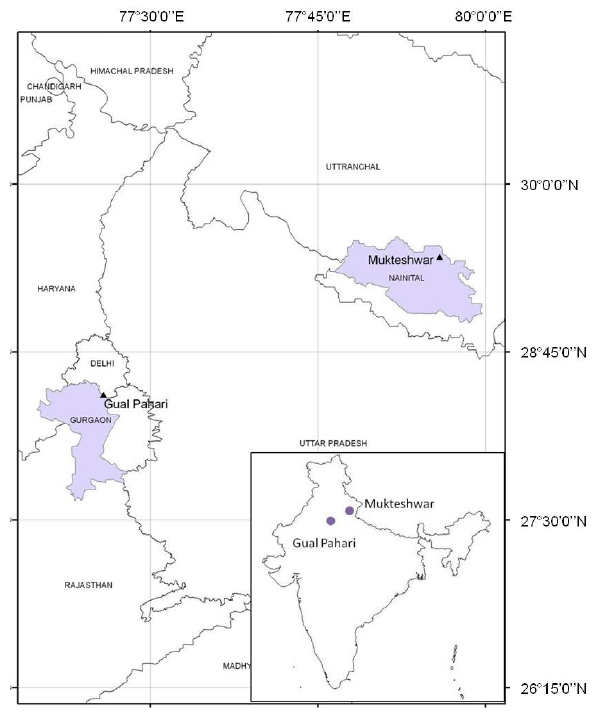
Fig. 1. Locations of the Gual Pahari and Mukteshwar measurement